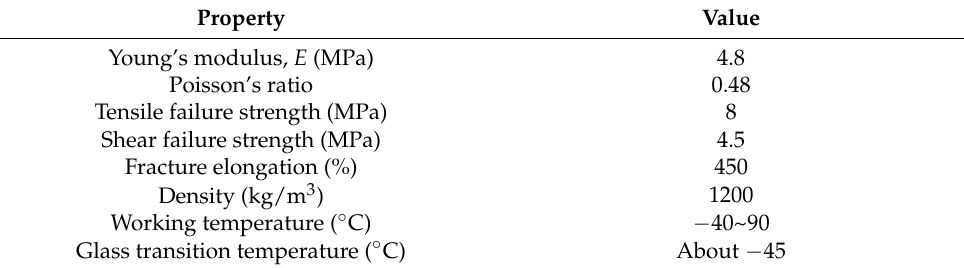
Table 2. Mechanical properties of